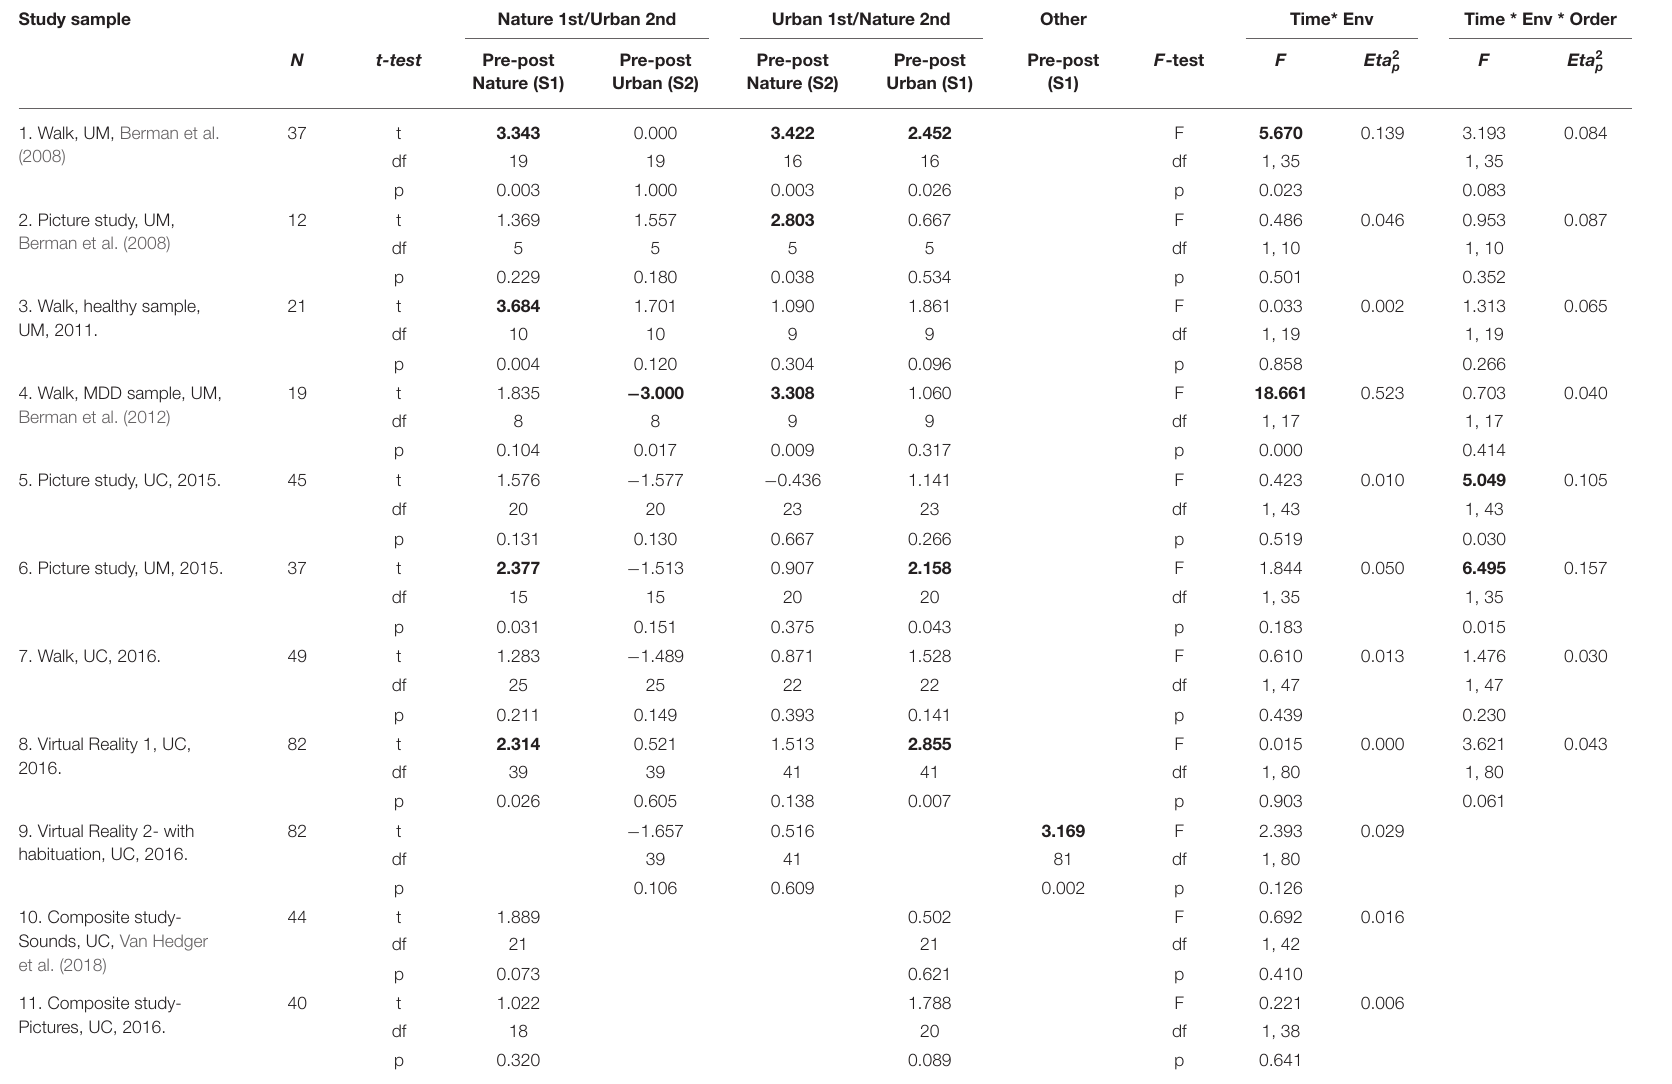
TABLE 3 | Effects on BDS performance from pre- to post environment exposures by study sample, and aggregated time (pre- vs. post environment) by environment conditions (nature vs. urban) by order effects on BDS across study samples. Study